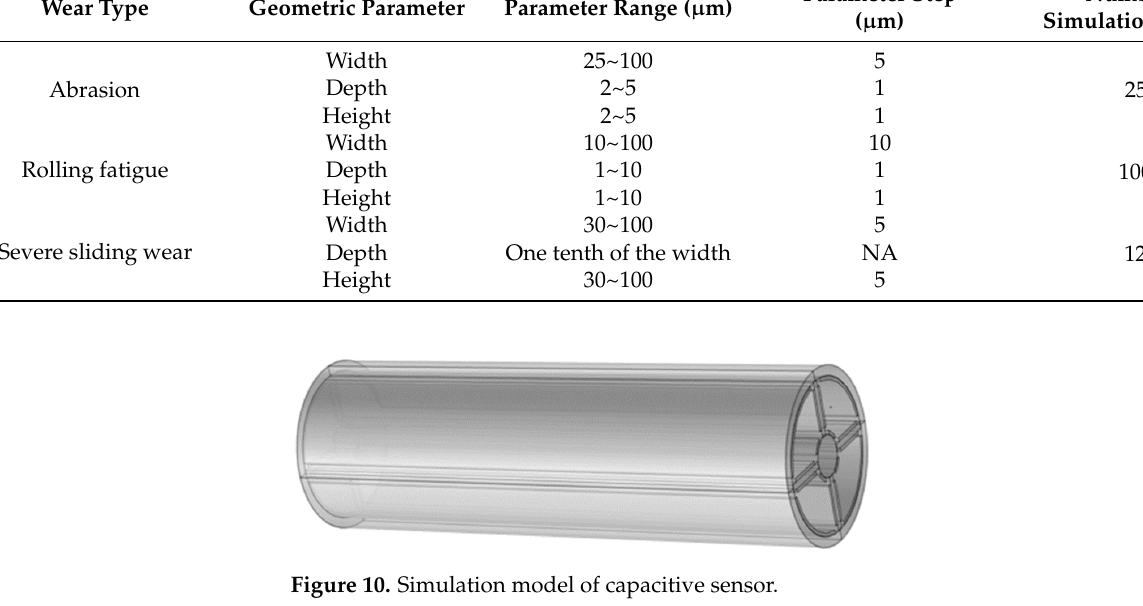
Figure 10. Simulation model of capacitive sensor.